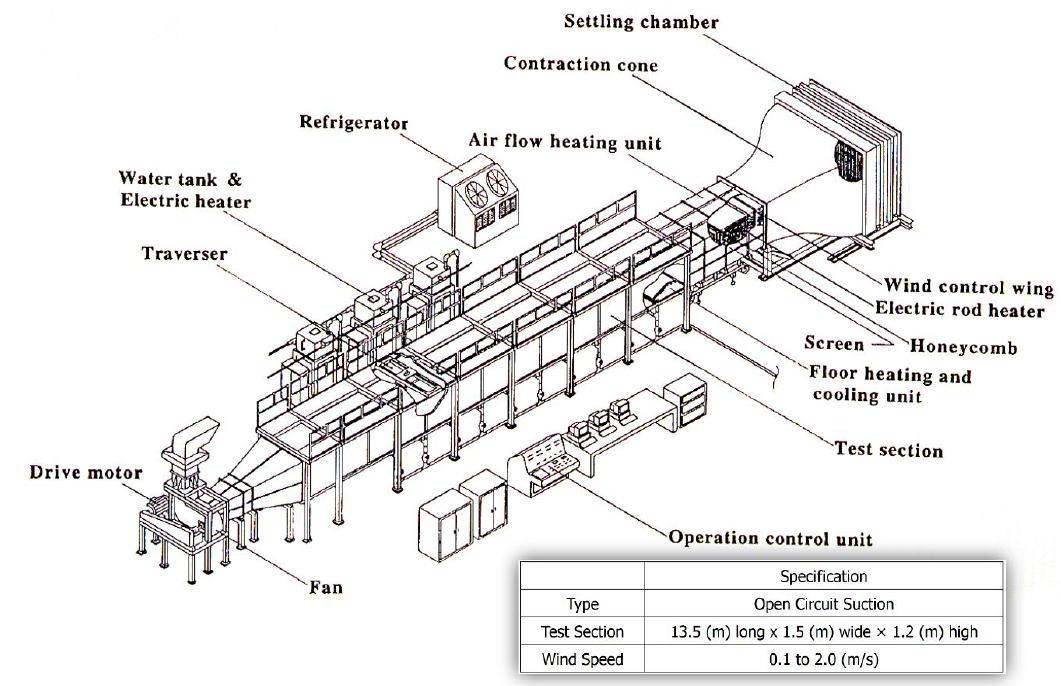
Figure 2. Overview of a thermally stratified wind tunnel.